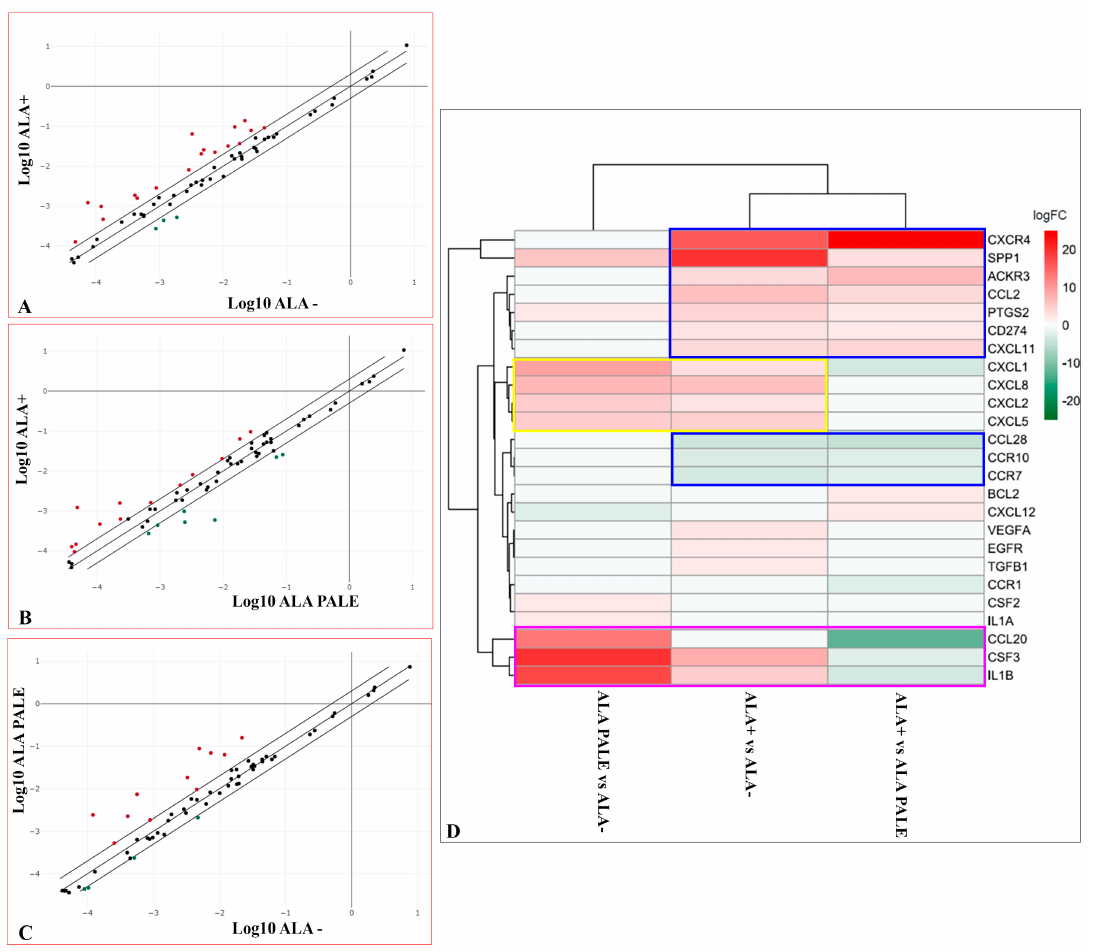
Figure 4. Comparison of the gene expression profile of GASC-ALA + , ALA PALE and ALA − using the cancer inflammation and immunity crosstalk RT 2 PCR Array. ( A – C ) Scatter plots comparing the expression of eighty-four cancer-related genes analysed using the RT2 Profiler ™ PCR Array. Scatter plots represent the mean of normalized expression of every gene between ALA + vs. ALA − ( A ), ALA + vs. ALA-PALE ( B ) and ALA-PALE vs. ALA − ( C ), respectively ( n = 6 per region). Using as a